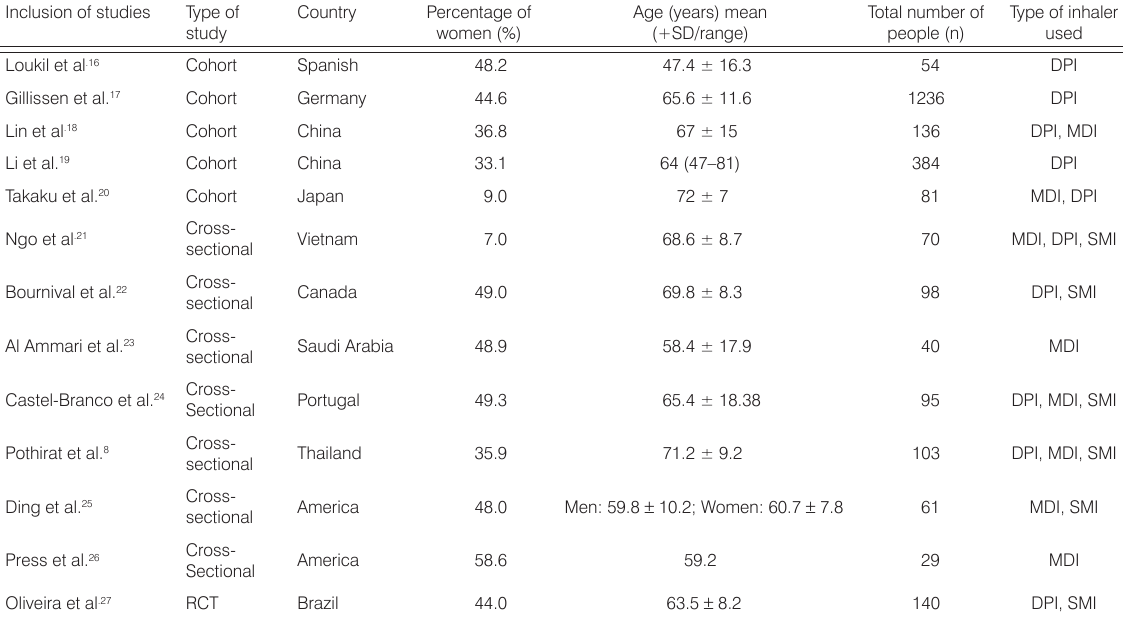
Table 1. Clinical characteristics of included